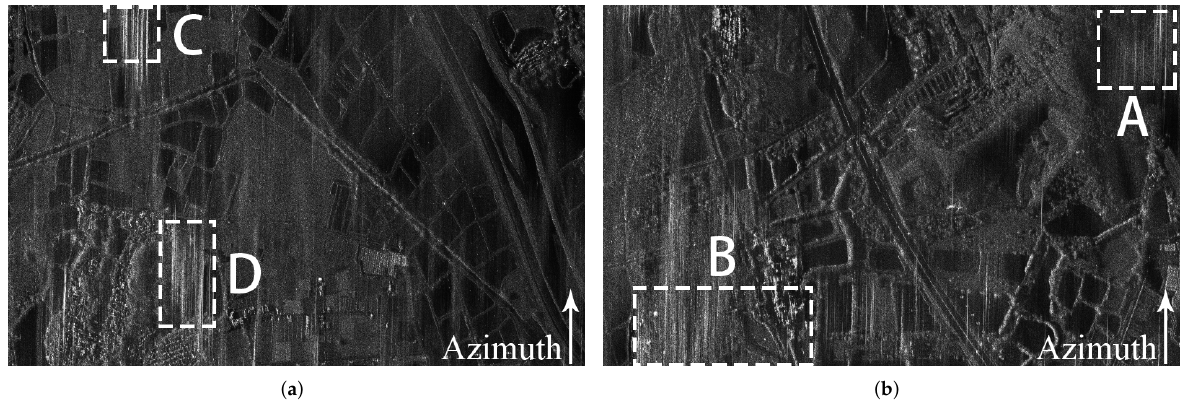
Figure 20. The single-channel images. ( a ) The near-end sub-swath. ( b ) The far-end sub-swath.